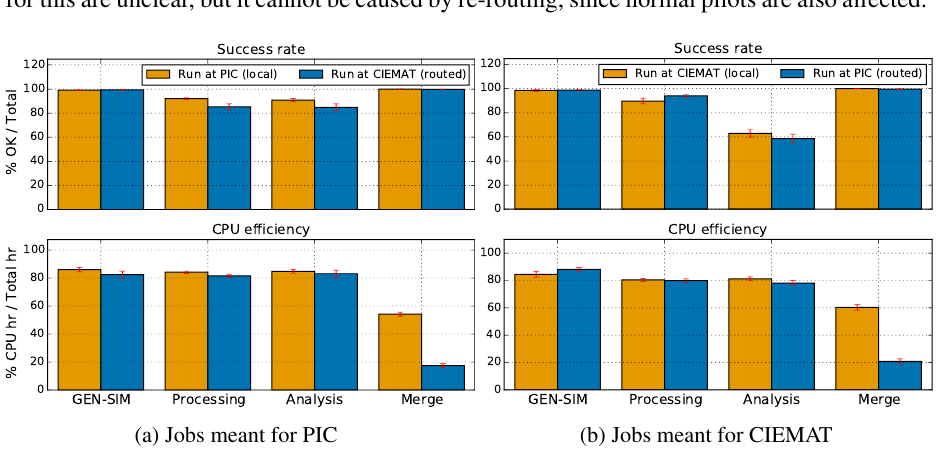
Figure 3: Success rate (top) and CPU e ffi ciency (bottom) by job type and target site, for normal (left / orange bars) and re-routed jobs (right / blue